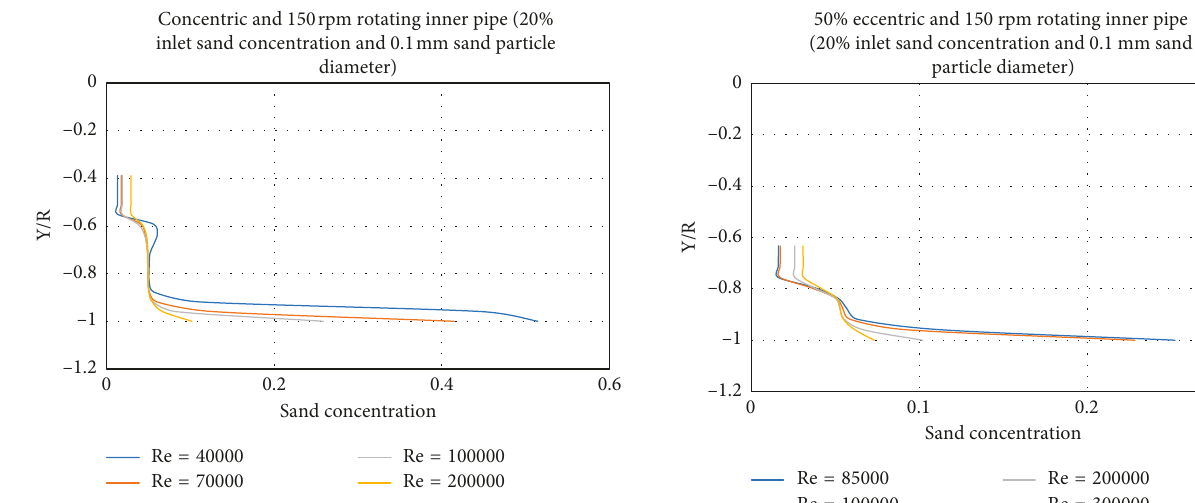
Figure 11: Effect of fluid flow on particle concentration profile (concentric annuli with 150rpm rotating inner pipe).